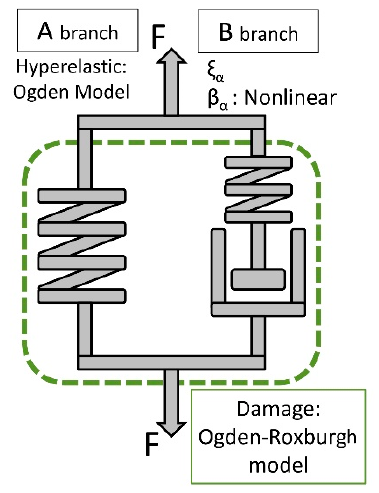
Figure 1. Rheological model representation.